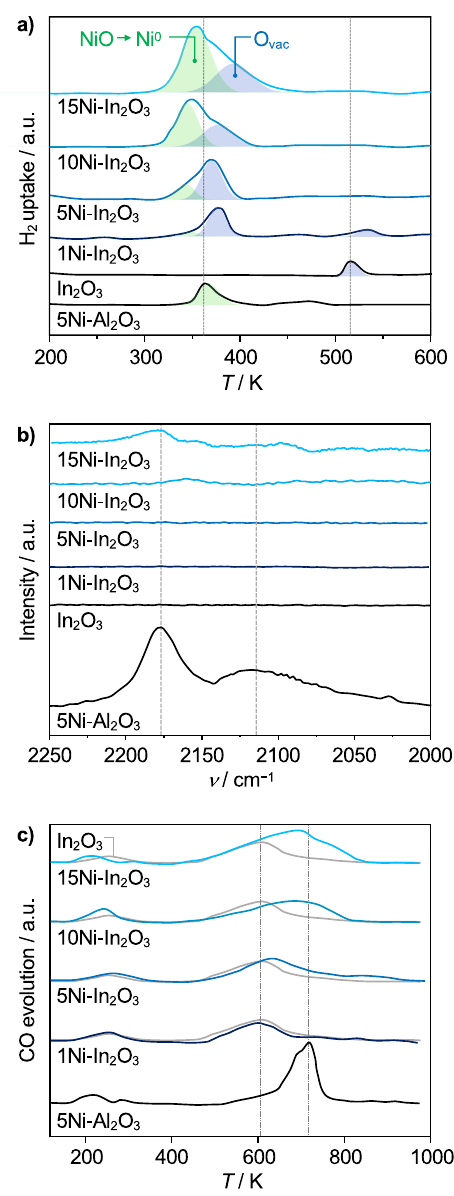
Fig. 2 Sensitivity of nickel-promoted In 2 O 3 catalysts to H 2 and CO. a H 2 - TPR at 5 MPa of pressure, b CO-DRIFTS, and c CO-TPD of Ni-In 2 O 3 catalysts prepared by DI containing 1 – 15 wt.% nickel, with unpromoted In 2 O 3 and 5Ni-Al 2 O 3 serving as references. Deconvoluted signals speci fi c to nickel reduction and oxygen vacancy formation on In 2 O 3 are colored in green and blue in ( a ). a.u. = arbitrary